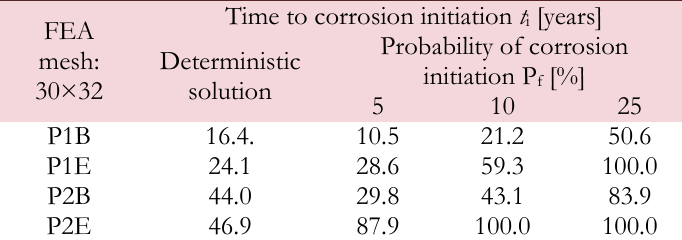
Table 3: Period to the initiation of corrosion t i [years] for a selected probability of the initiation of corrosion for selected variants according to type of reinforcement protection: B - unprotected steel reinforcement, E - reinforcement covered with epoxide; the bridge deck construction: 1 - ordinary concrete and a directly exposed bridge deck with a crack, 2 - ordinary concrete and a bridge deck with a crack protected by waterproof insulation under an penetrable asphalt